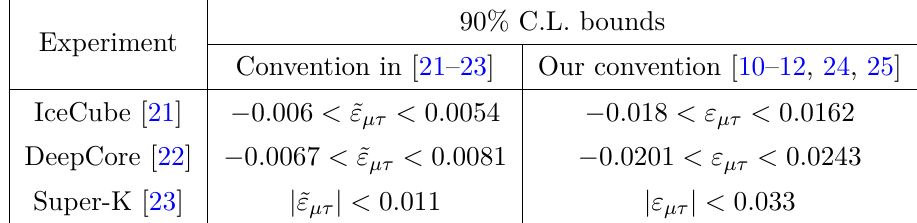
Table 1 . Existing bounds on ε µτ at 90% confidence level. Note that the bounds presented in [21– 23] are on ˜ ε convention V in [21–23] on ˜ ε third